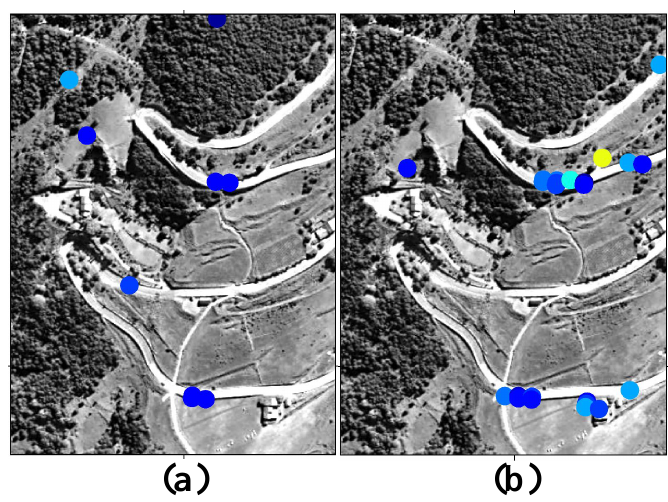
Figure 15. The LOS ground displacement velocity maps, Sentinel-1A SAR images. Enlargement of the red rectangles inside Figure 14. ( a ) D A method; ( b ) TPC method. The color scale for the displacements is the same as that in Figure